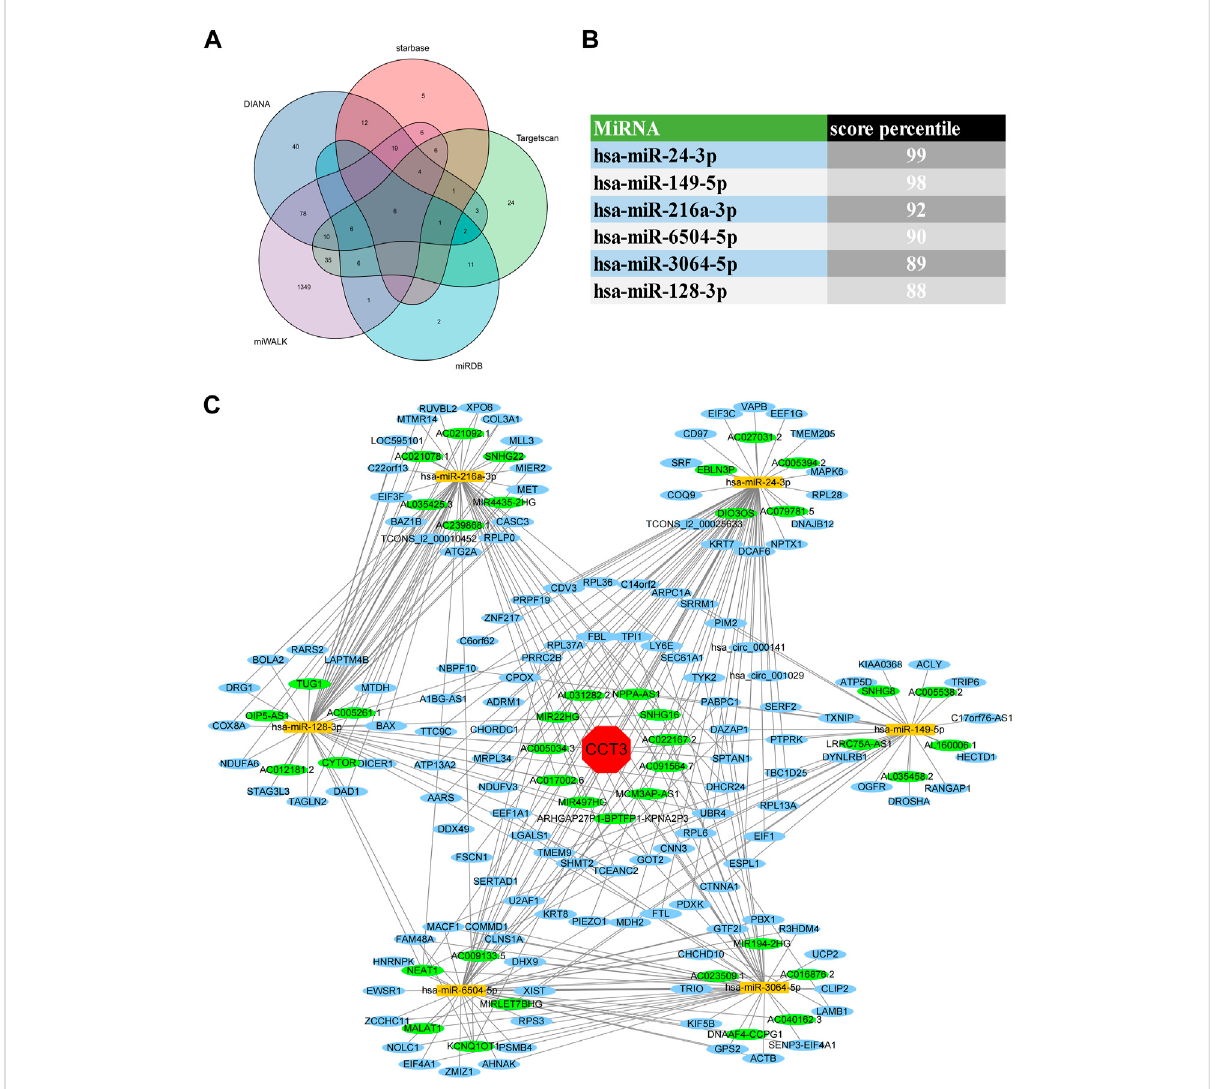
CeRNA regulatory network analysisfor CCT3. (A) The Venndiagramsshowed thepredictedmiRNAscomplementary to CCT3 3 ′ UTR region. (B) Targetscan database showed the score percentile of the predicted six miRNAs. (C) The ceRNA regulatory network for CCT3 was constructed by